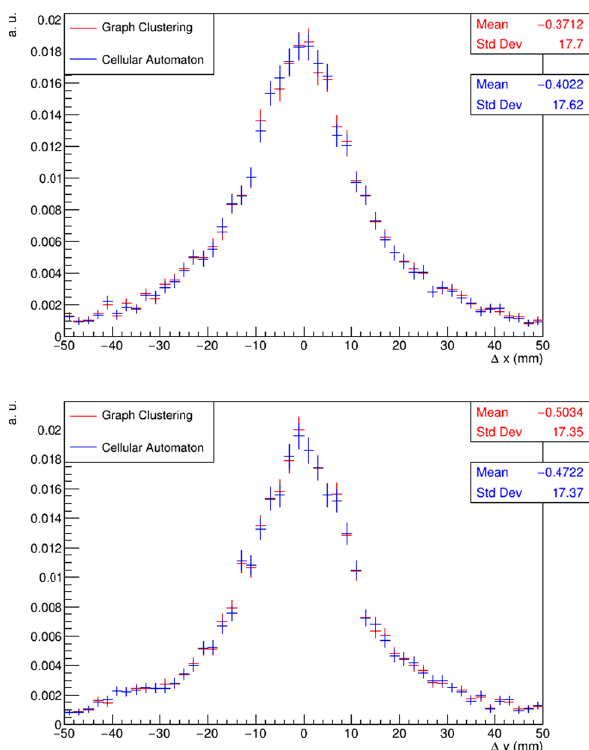
Fig. 6 Normalized histograms of the X axis resolution at the top and the Y axis resolution at the bottom. Both using π 0 samples and clusters with a match fraction over 0 . 9 with no corrections